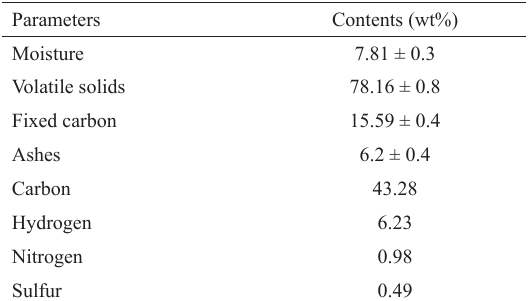
phase) and calcium-sodium silicate, JCPDS 00.023-0671